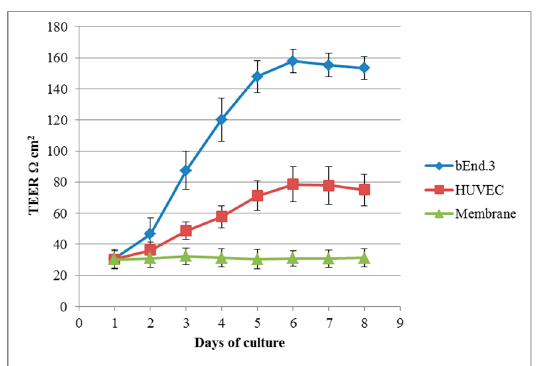
Figure 5. Trans-endothelial electrical resistance (TEER) measurement of the cultured bEnd.3 cells, human umbilical vein endothelial cells (HUVEC) and cell-free inserts (membrane).